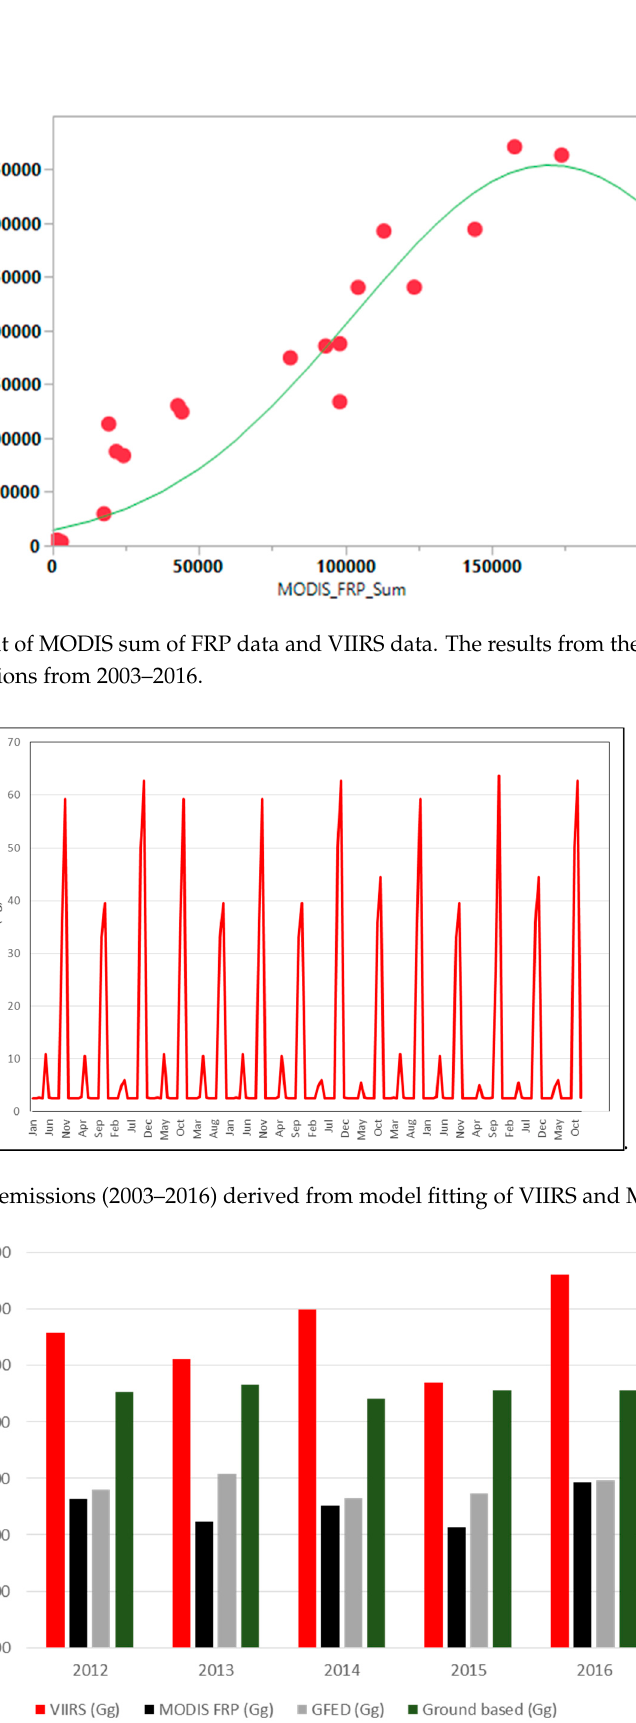
Figure 11. Comparison of TPM emissions from different datasets. VIIRS based emissions were found to be significantly higher than all other datasets.